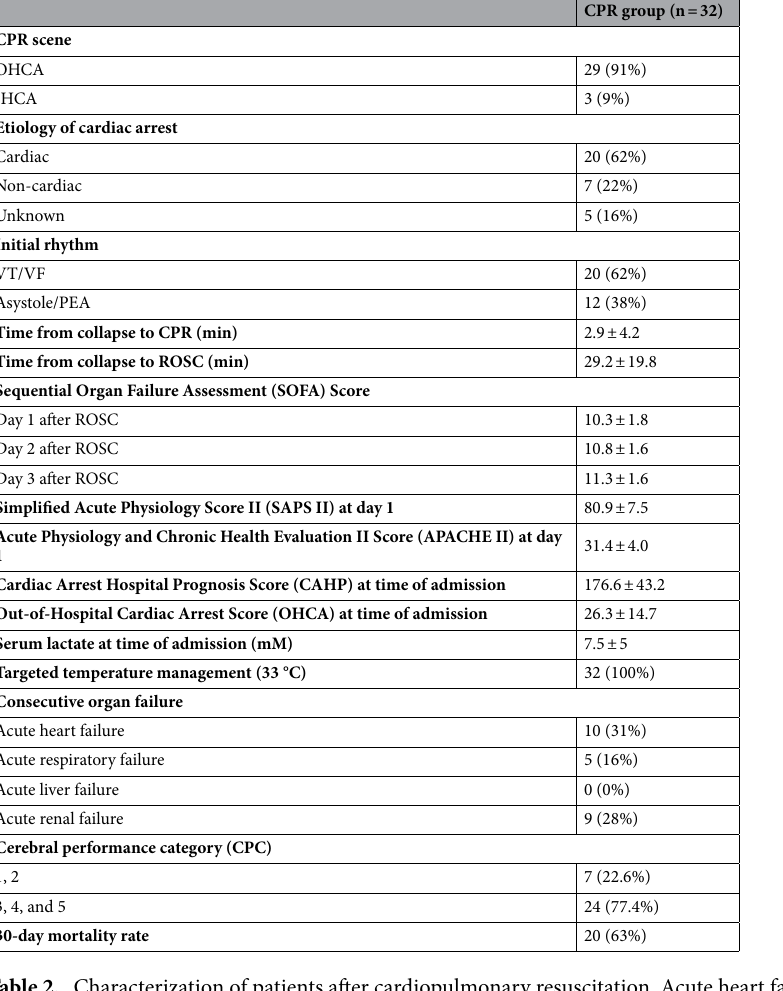
Table 2. Characterization of patients after cardiopulmonary resuscitation. Acute heart failure was defined by clinical signs of cardiac decompensation or cardiogenic shock. Acute renal failure was defined as an increase in serum creatinine ≥ 0.3 mg/dl or an ≥ 1.5-fold increase from baseline creatinine within the first 48 h. Acute liver failure was defined as an increase in total bilirubin serum levels and an increase in the International Normalized Ratio above the reference values of our central laboratory. Acute respiratory failure was defined based on an oxygenation index (ratio of PaO 2 (mmHg) and FiO 2 (%)) ≤ 200 mmHg. CAHP and OHCA score were only calculated in patients after out-of-hospital cardiac arrest. One patient was lost to follow-up after study enrollment. CPR cardiopulmonary resuscitation, OHCA out-of-hospital cardiac arrest, IHCA in-hospital cardiac arrest, VT ventricular tachycardia, VF ventricular fibrillation, PEA pulseless electrical activity, ROSC return of spontaneous